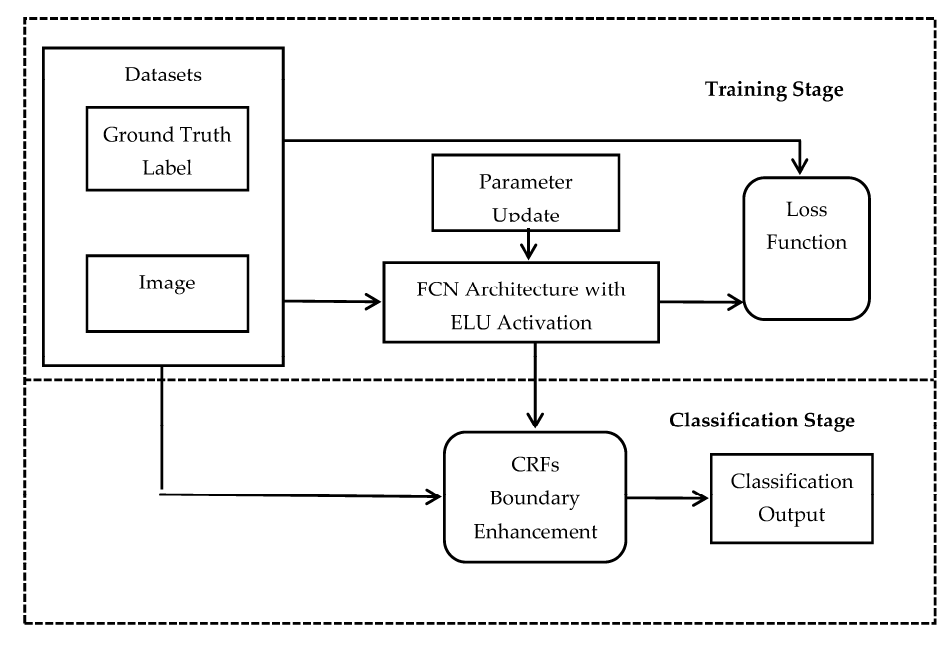
Figure 1 . General pipelines of our proposed approach: the training stage and the classification stage. Network Architecture